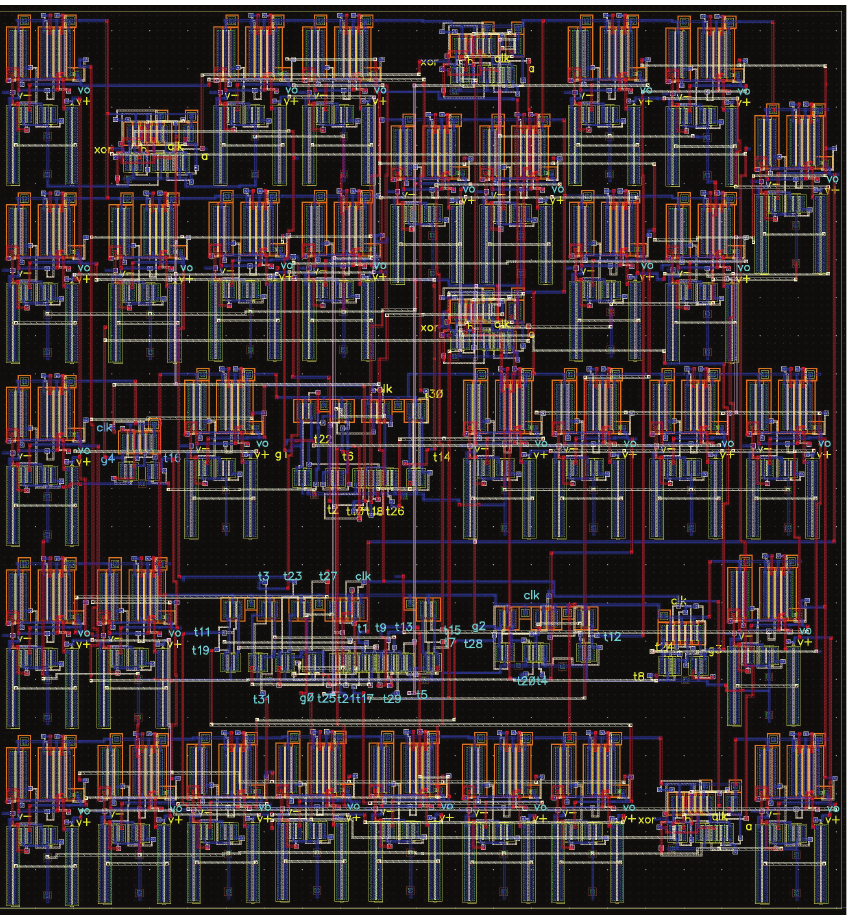
Figure 12: RC extracted layout of flash ADC.